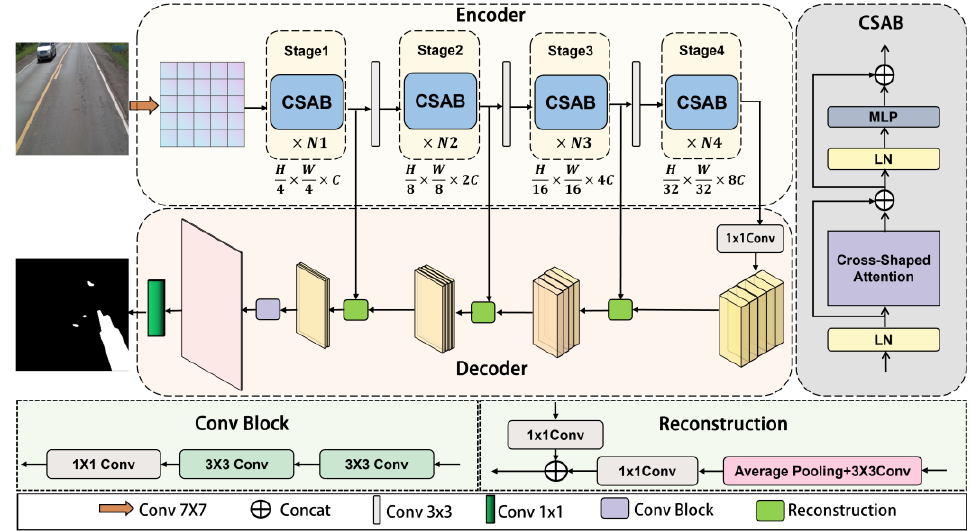
Figure 1. Overview of the proposed DMTC. Our network receives road images as input. The CSAB module uses a cross-attention mechanism to obtain bit-time multiscale feature information with rich contextual semantics. The DMFL module progressively integrates the extracted multiscale feature information. Finally, the road pothole segmentation results are output through a fully connected convolutional network.